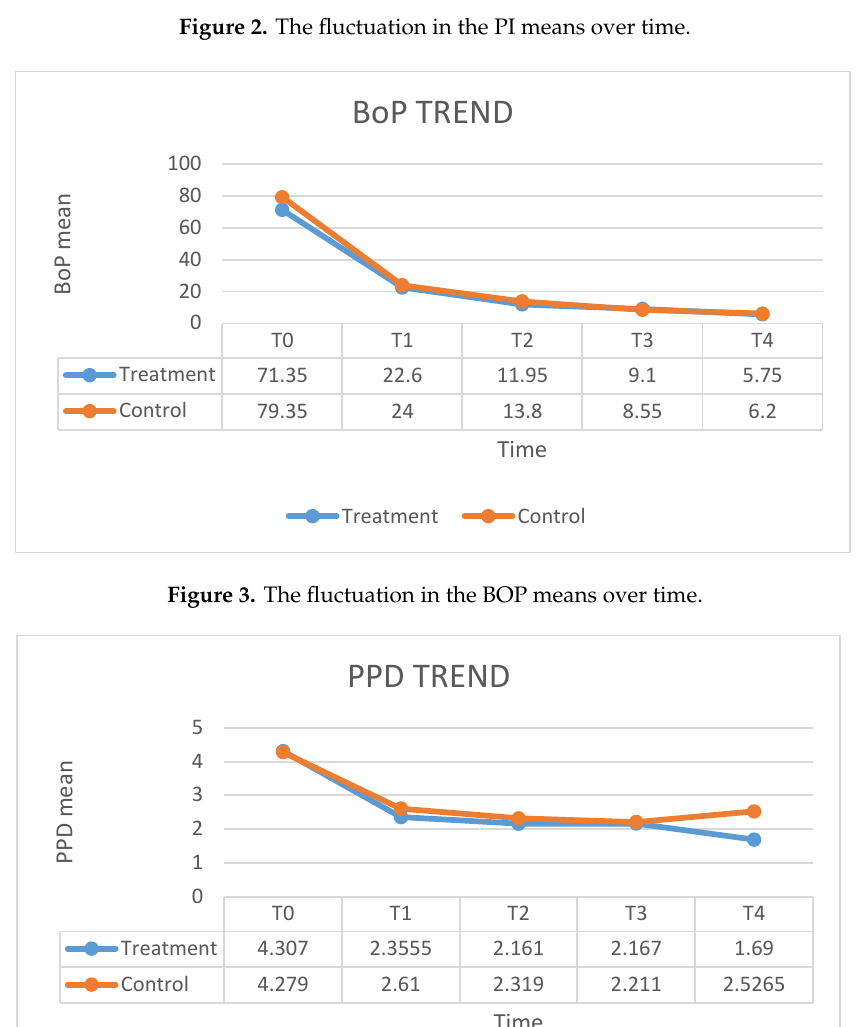
Figure 4. The fluctuation in the PPD means over time.